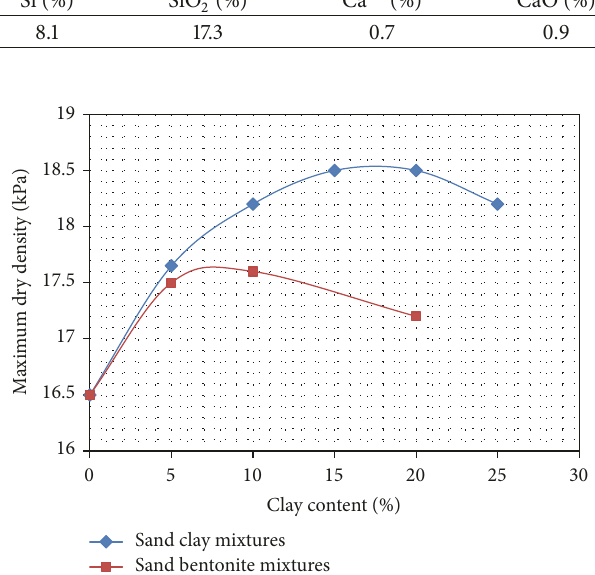
Figure 3: Maximum dry density-clay content relationships of sand- clay mixtures and sand-bentonite